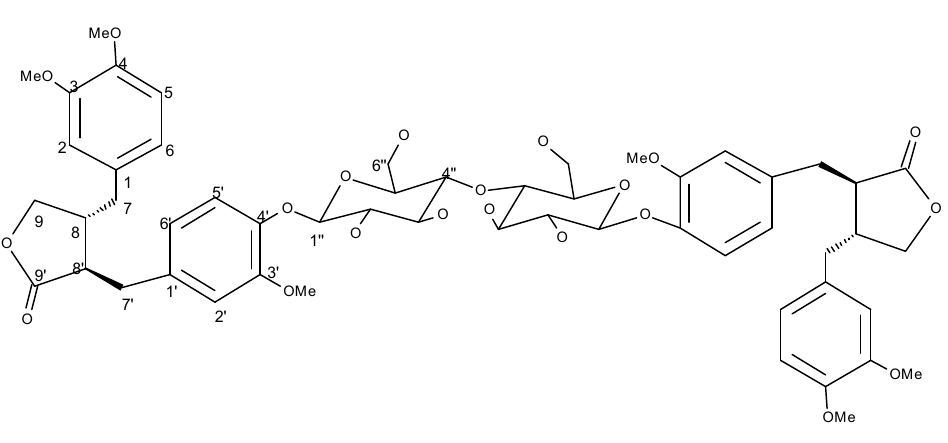
Figure 3. Structure of compound 3